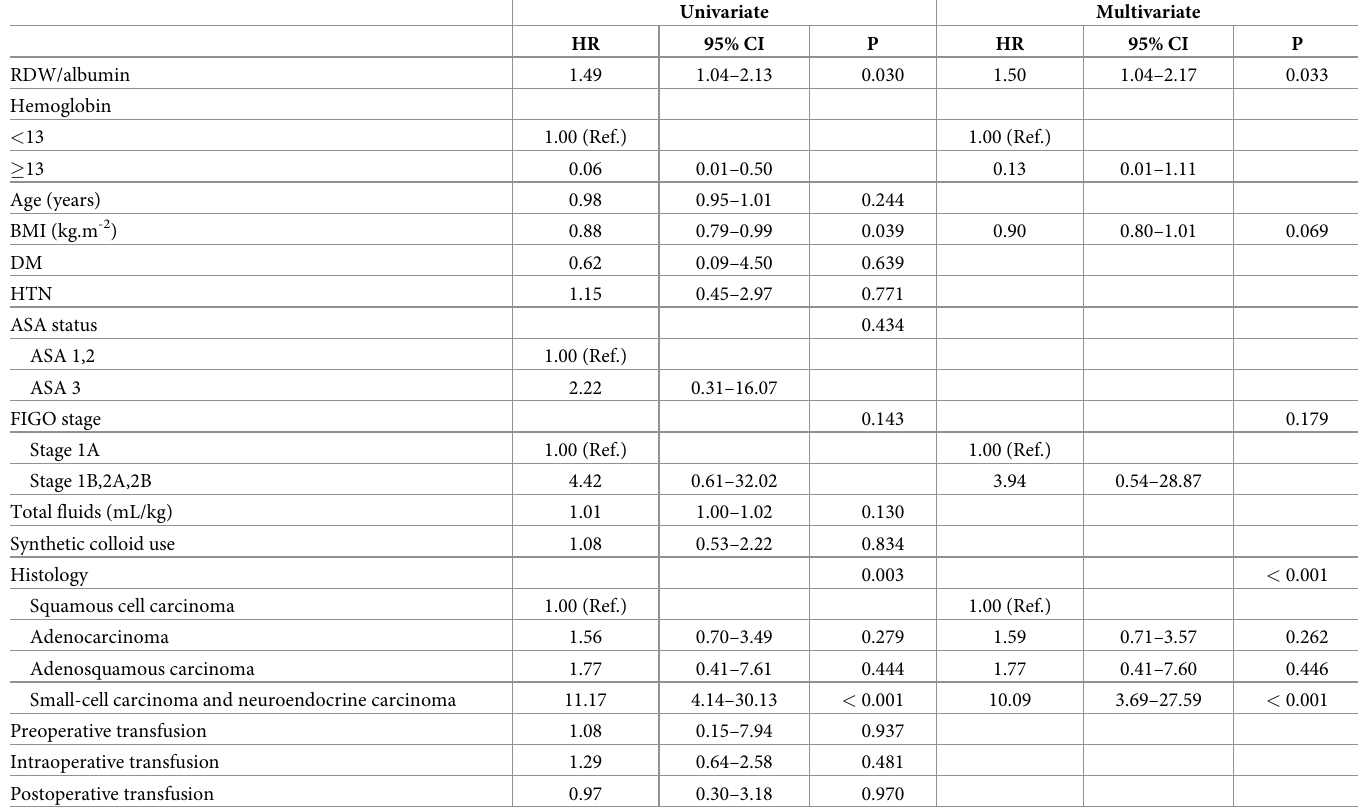
Table 4. Cox regression analysis of 5-year